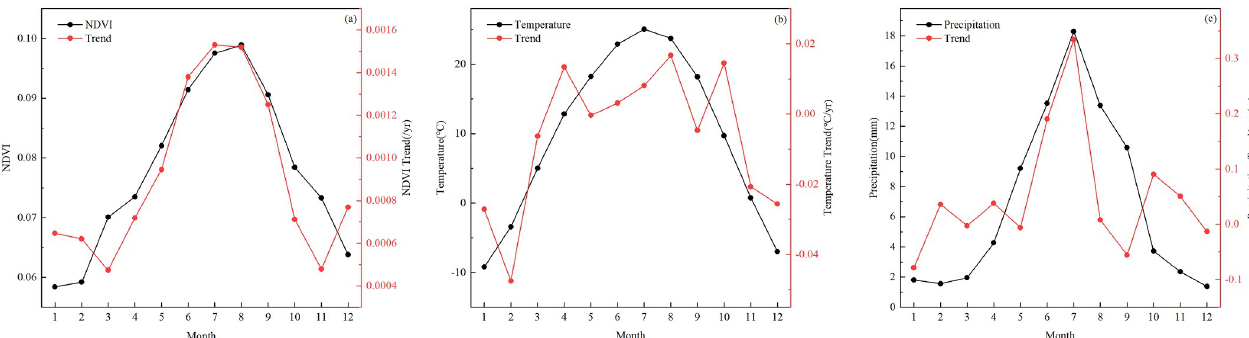
Fig 3. Mean values (black lines) and trends (red lines) of the monthly NDVI (a), temperature (b), and precipitation (c) in desert areas from 2000 to 2017.